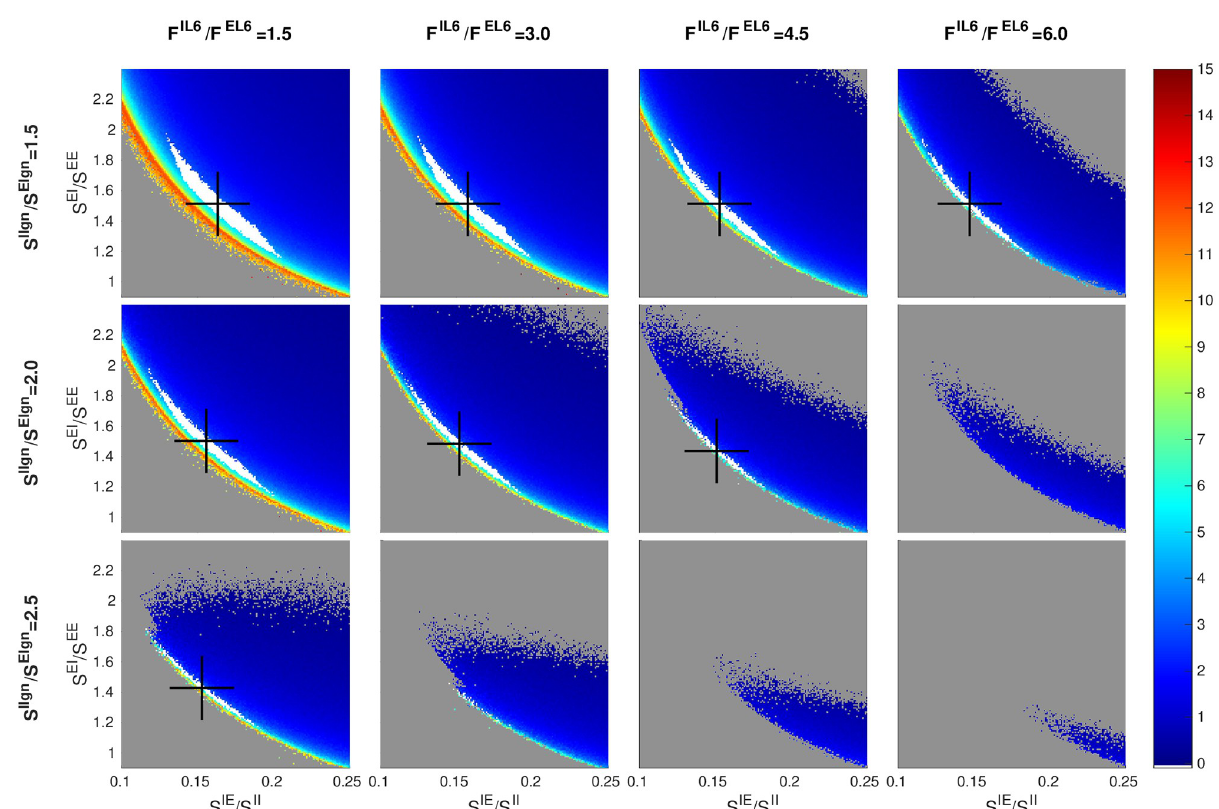
Fig 3. Dependence of firing rate and good area on LGN versus L6. A 3 × 4 matrix of panels is shown: each row corresponds to a fixed value of S I lgn / S E lgn and each column a fixed value of F I L6 / F E L6 . Smaller panels depict f E maps on inhibition planes and are as in Fig 2. The panel for F E L6 / F I L6 = 3 and S I lgn / S E lgn = 2 (row 2, column 2) corresponds to the f E rate map in Fig 1. Other free parameters are S EE = 0.024, S II = 0.12, and S E lgn = 2 × S EE .